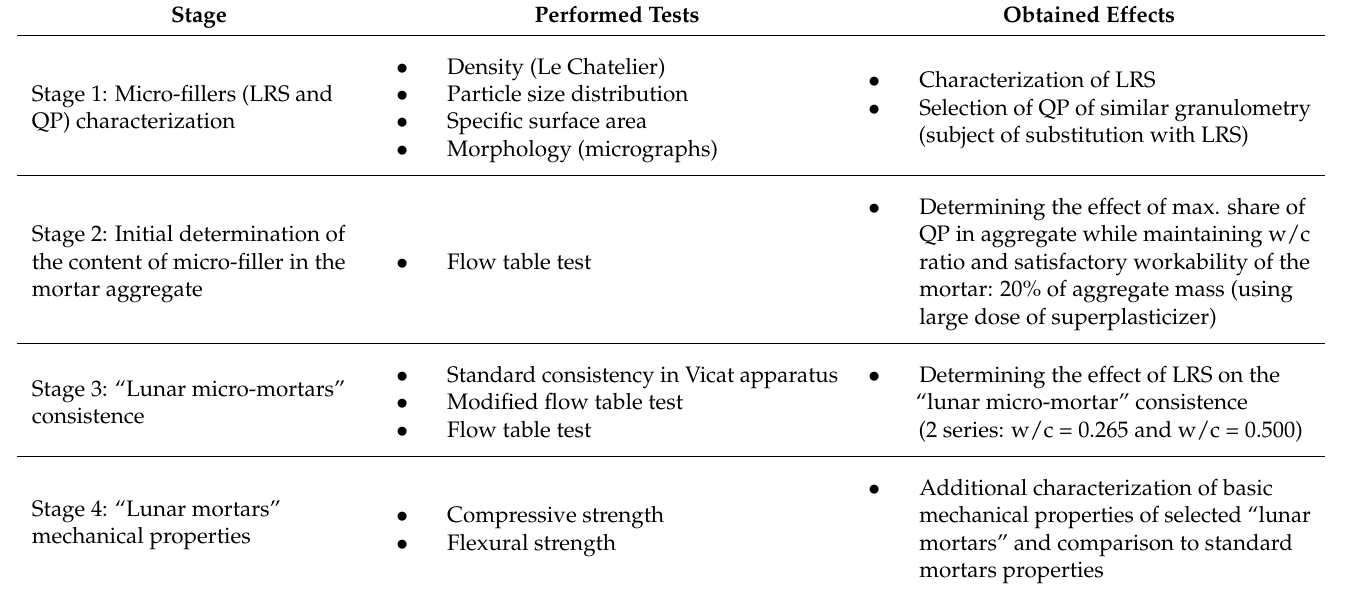
Table 2. Stages of the experimental program (LRS—lunar regolith simulant; QP—quartz